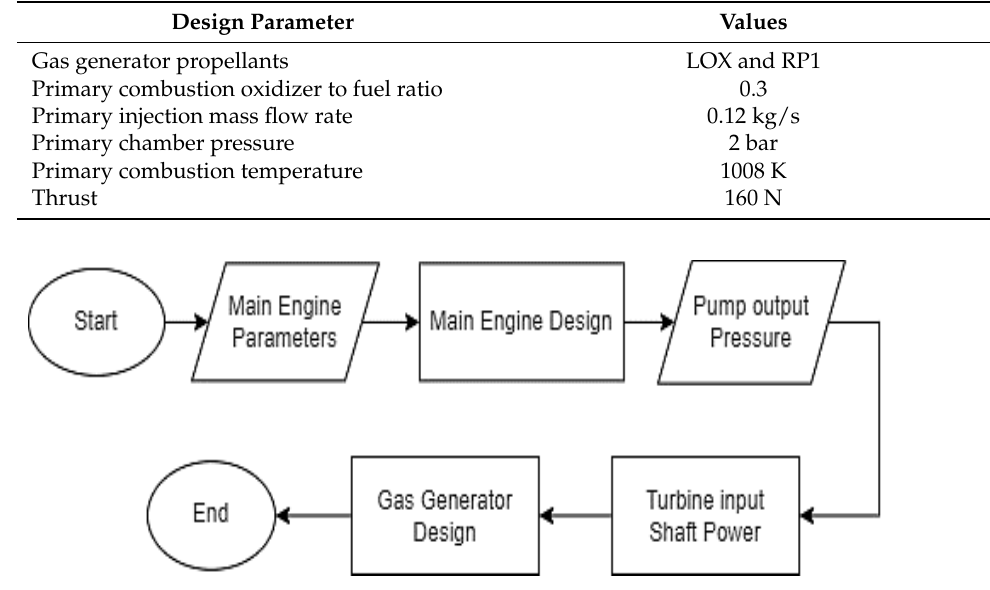
Table 2. Gas generator design parameters. Figure 1. Flow chart for a gas generator LPRE cycle calculation. Table 1. Main rocket engine design parameters.